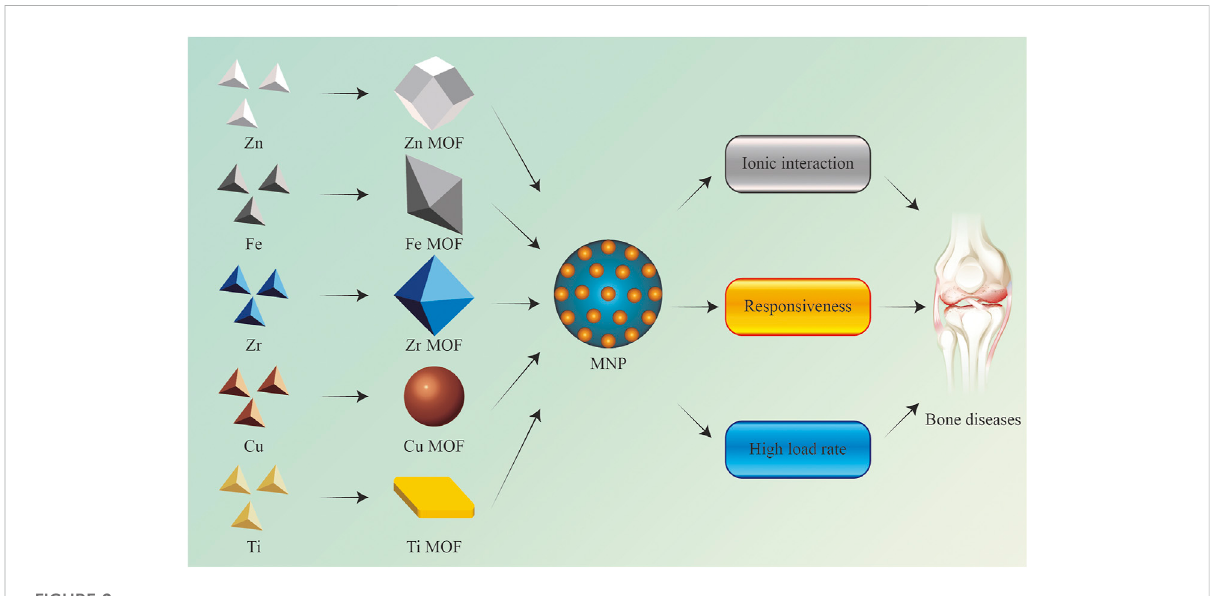
FIGURE 2 Important components of MNPs: classi fi cation and advantages of